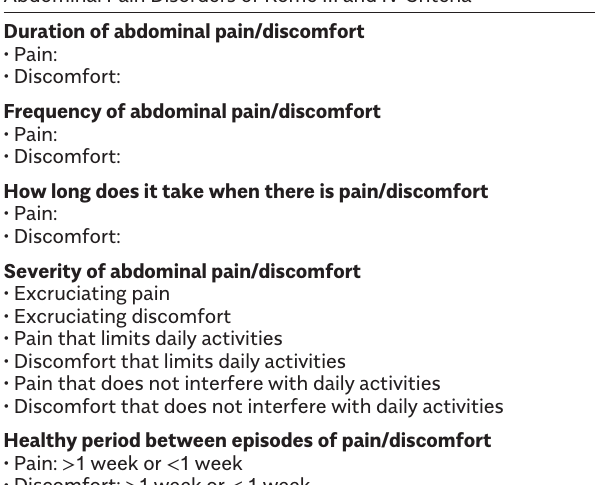
Table 1. Questionnaire by Adapting the Pediatric Gastrointestinal Symptom Questionnaire for Rome III and IV Criteria Pediatric Gastrointestinal Symptom Questionnaire for Functional Abdominal Pain Disorders of Rome III and IV Criteria Duration of abdominal pain/discomfort •